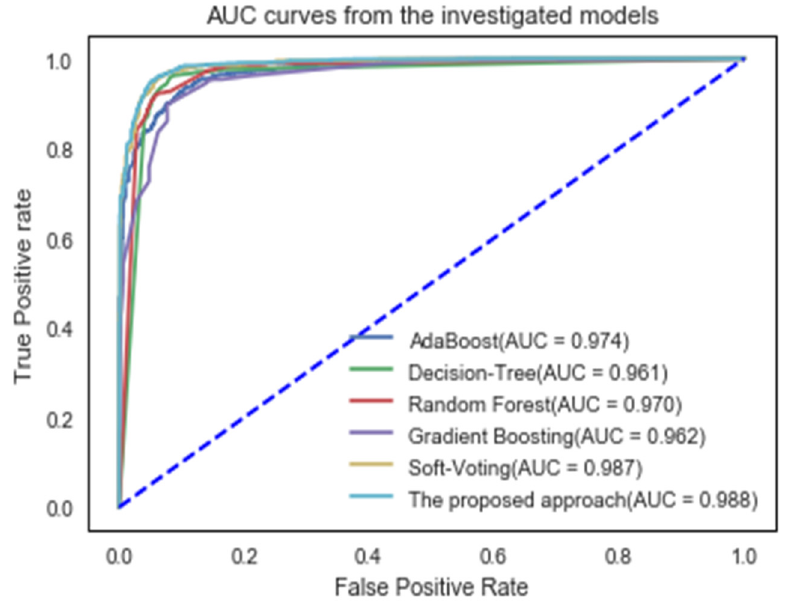
Figure 4. AUC curves of the suggested classifier and some machine learning techniques.